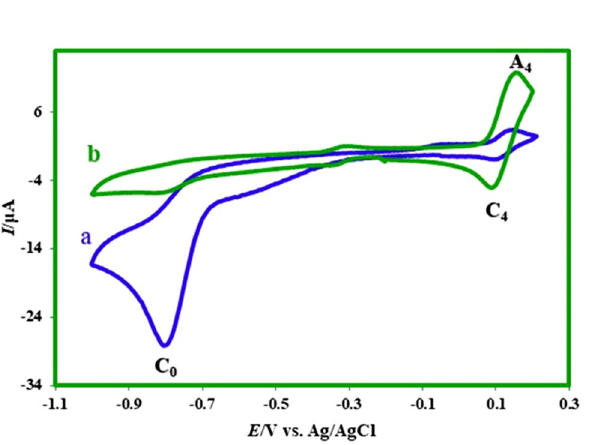
Figure 18. Cyclic voltammograms of 0.2 mmol nitro mefenamic acid in the controlled potential coulometry at − 0.8 V versus Ag/AgCl after consumption of: (a) 0 and (b) 120 C in phosphate buffer solution (c = 0.2 M, pH 7.0); Scan rate 100 mV s −1 ; Room